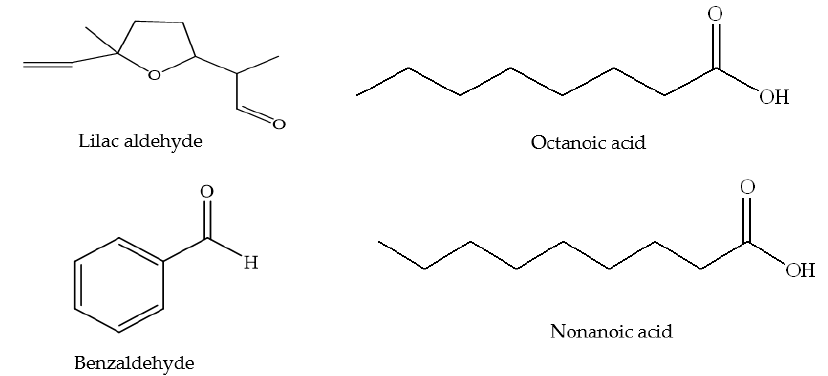
Figure 10. Volatile constituents of red clover honey.